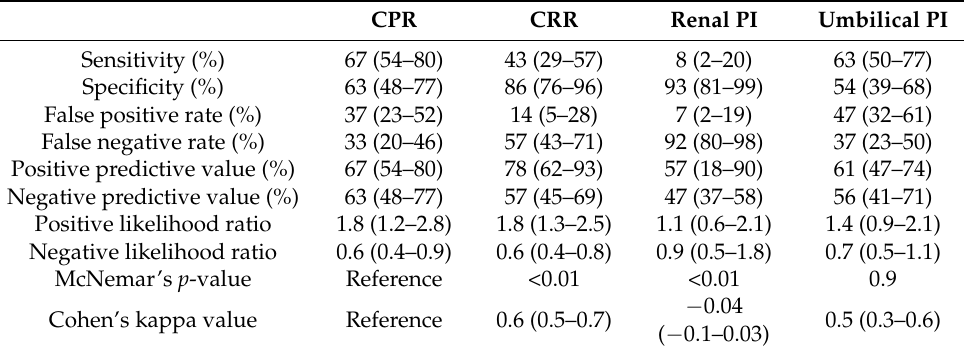
Table 4. Test characteristics for composite neonatal outcome and 95% confidence intervals.